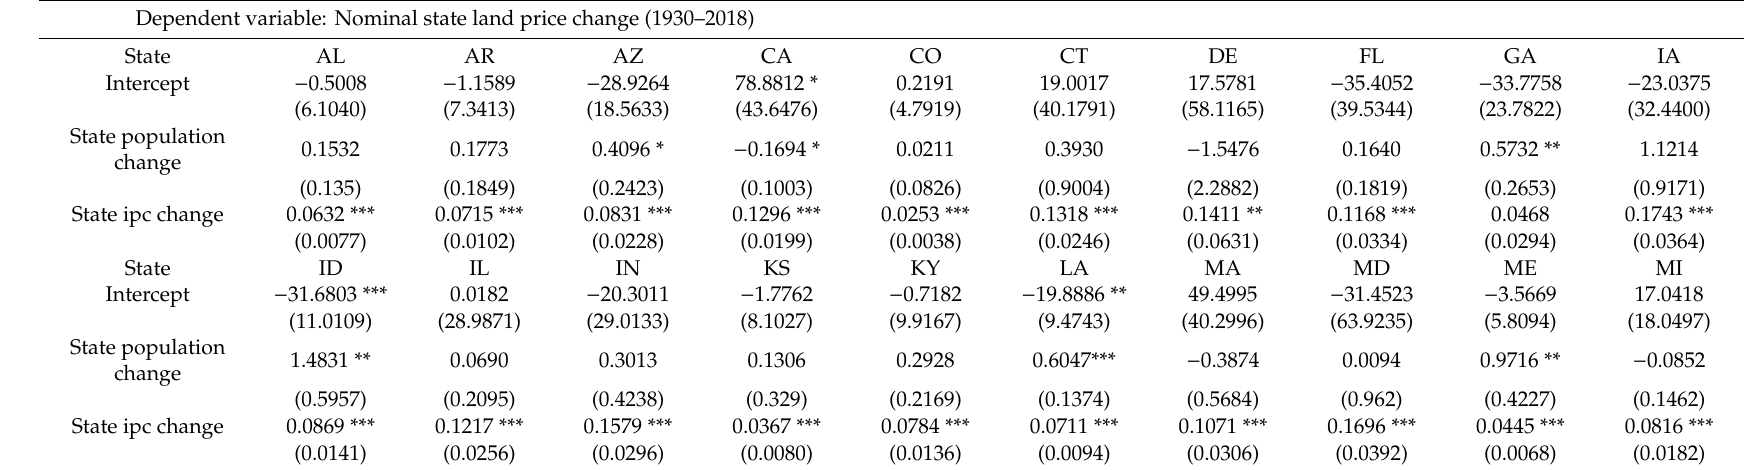
Table A2. The impact of state level population growth and income per capita growth on agriculture land price growth, nominal